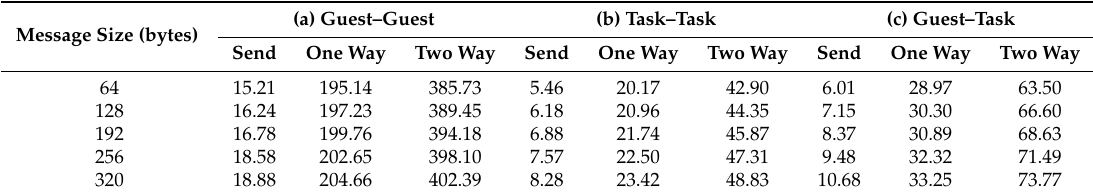
Table 4. Synchronous IPC communication latency ( µ